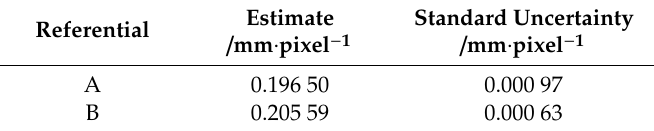
Table 7. Cross-section area measurements in tested masonry specimens.